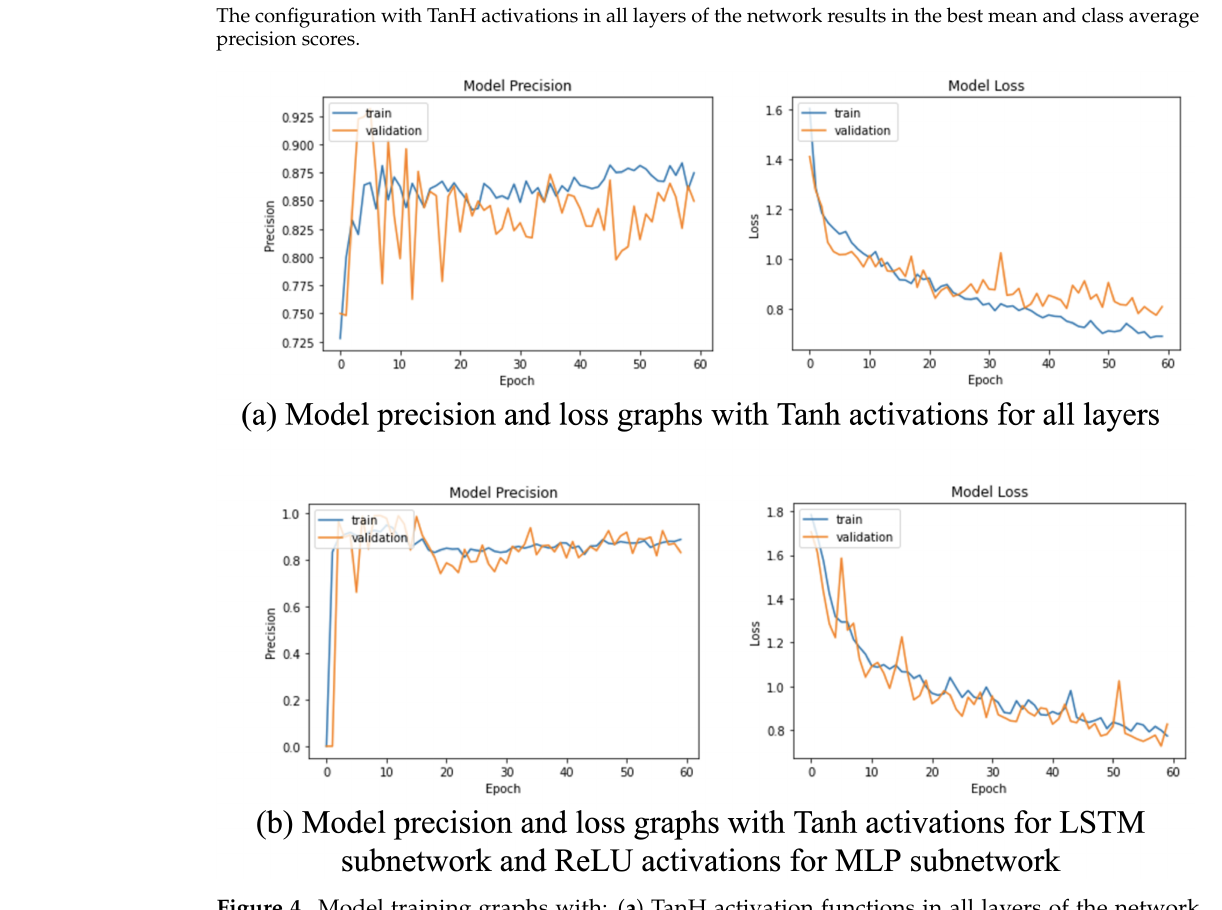
Figure 4. Model training graphs with: ( a ) TanH activation functions in all layers of the network and ( b ) TanH activations in the LSTM sub-network and ReLU activation functions in the MLP